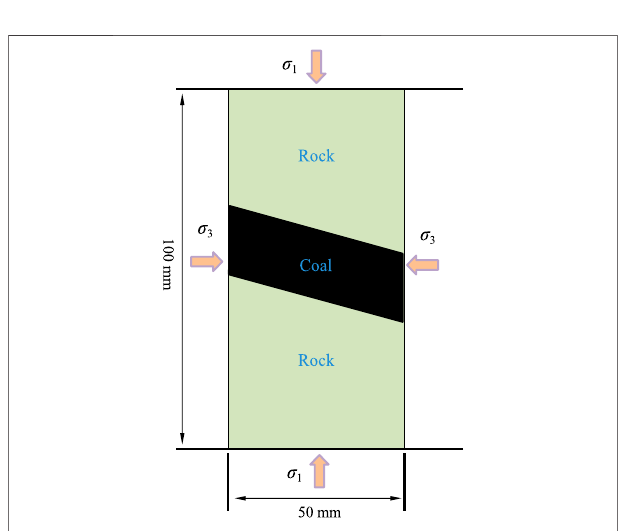
FIGURE 2 | Schematic diagram of numerical model loading of the RCR composite samples.